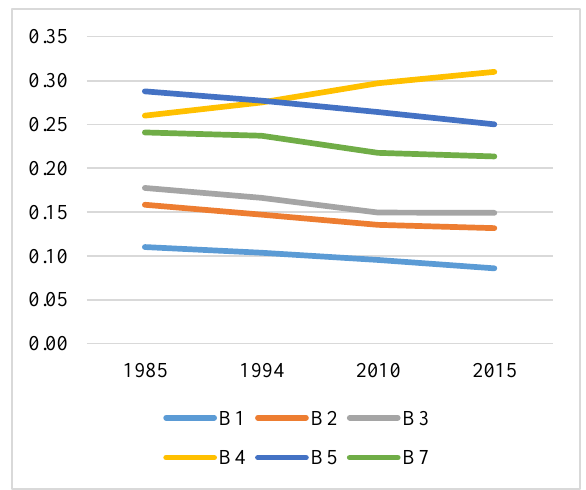
Table 1. Indices used in this study *NIR is the reflectance in near-infrared band, RED is the reflectance in Red band.